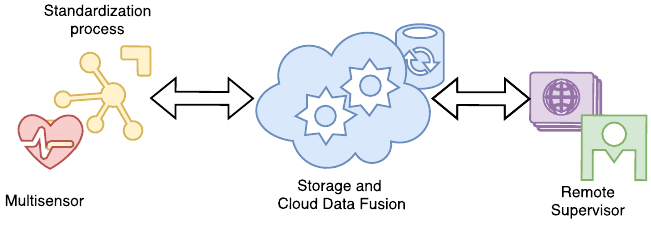
Figure 1. Scheme of our eHealth monitoring